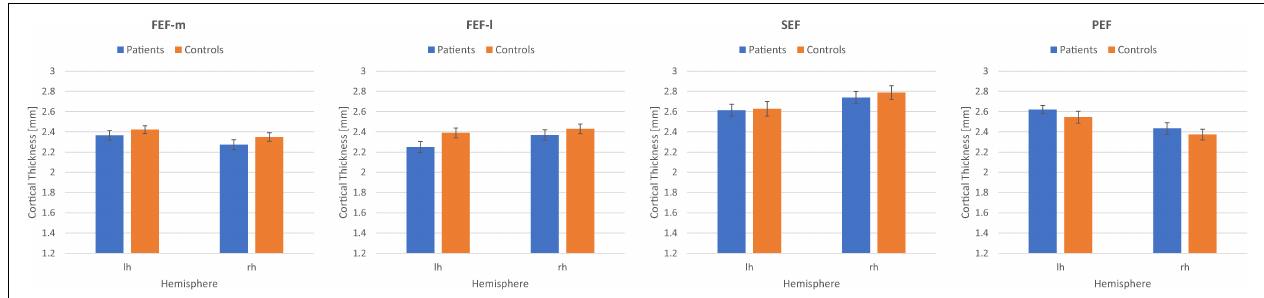
FIGURE 5 | Mean cortical thickness measures in mm together with their respective standard errors for the eye fields FEFm, FEFl, SEF, and PEF in the left (lh) and right (rh) hemisphere for the patient group ( N = 32) and the control group ( N = 32).